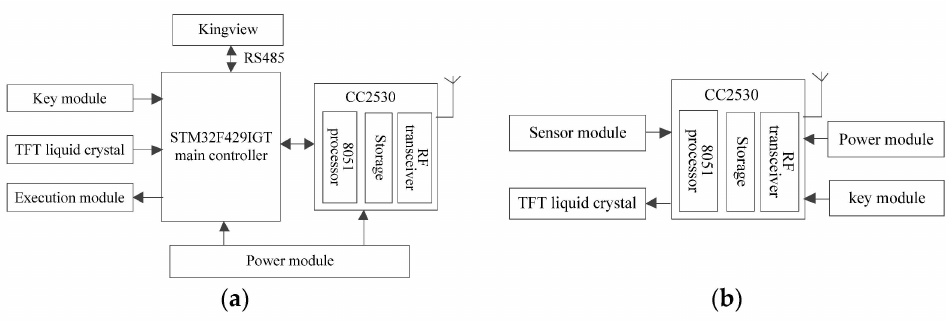
Figure 4. Node schematic diagram. ( a ) Coordinator node schematic diagram; ( b ) Terminal node schematic